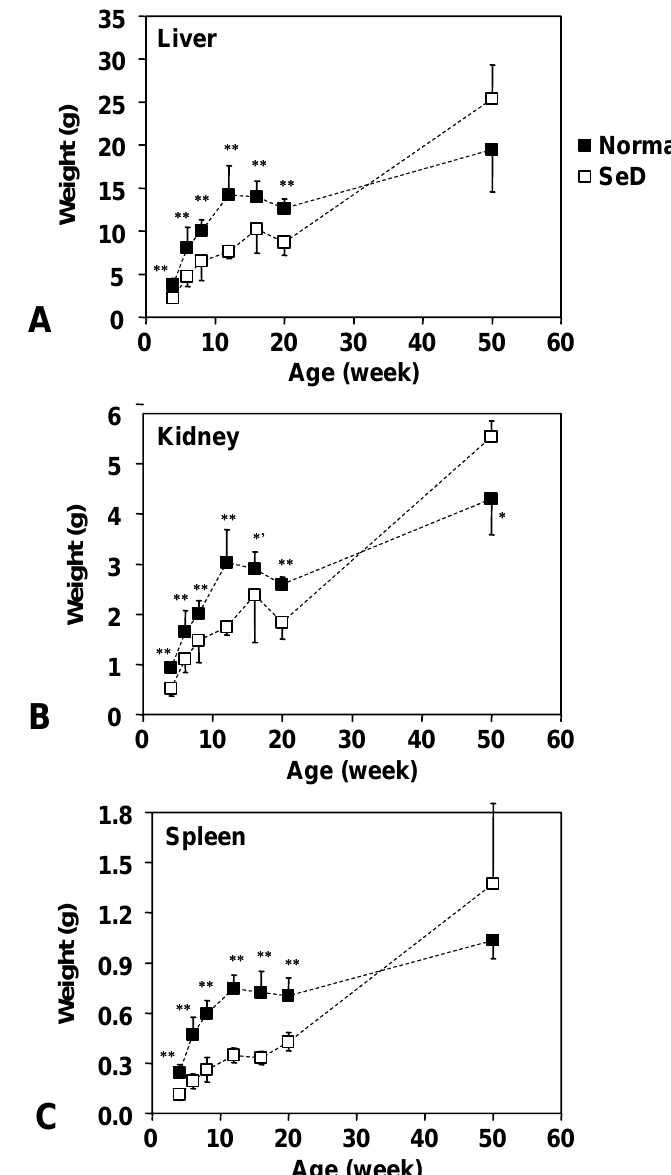
Figure 2. Dependence of weights of the lever, kidney, and spleen of normal and SeD rats on the age of rats. Values are indicated as the mean ± SD. * , *’ , and ** indicate significance between normal and SeD groups at p < 0.05, p < 0.01, and p < 0.001,